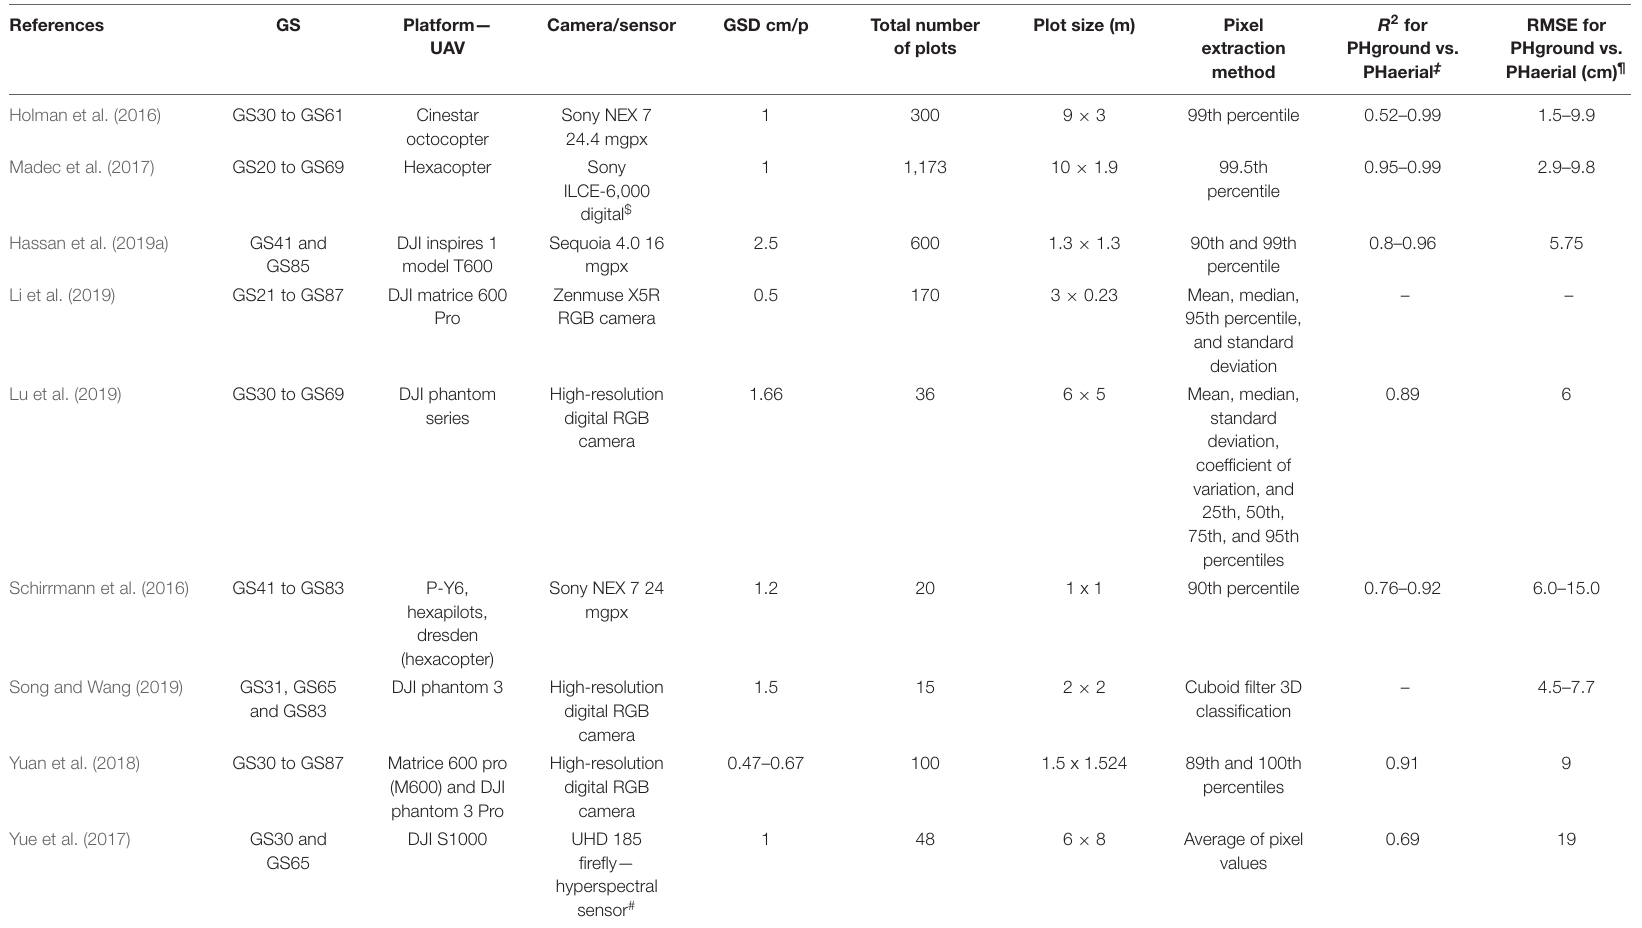
TABLE 1 | Summary of published studies on the estimation of plant height (PH) for wheat from RGB imagery acquired using unmanned aerial vehicles